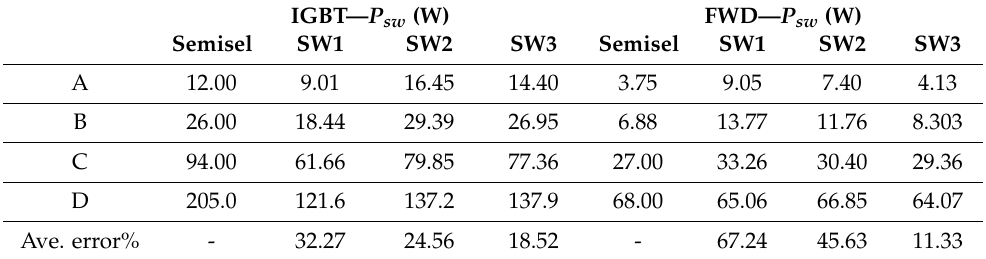
Table 9. Switching losses comparison, V DC = 600 V.